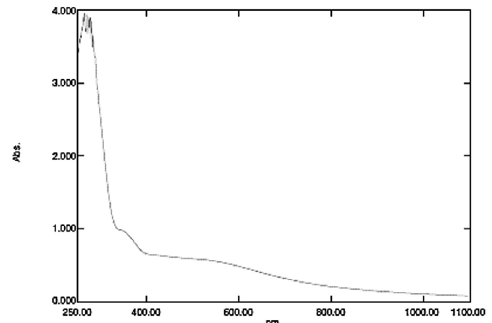
Fig. 1. UV Visible spectroscopy of crude silver nanoparticles